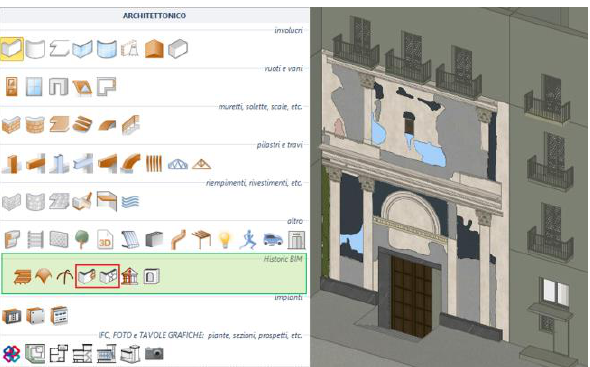
Figure 9 . Data implementation: informative sheets (web-based